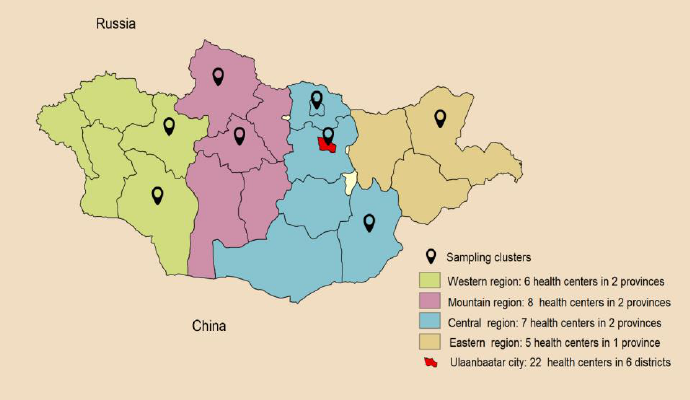
Figure 1. Sampling